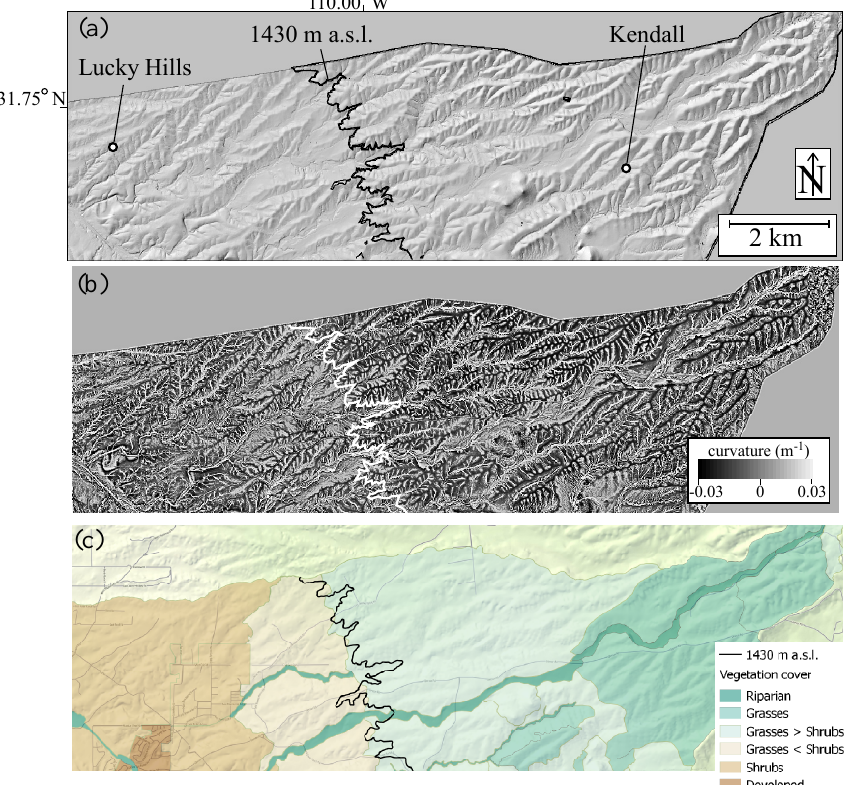
Figure 2. Relationships among landscape morphology and vegetation cover in the study area. (a) Shaded relief image of the topography, illustrating the significant increase in hillslope-scale relief from the western to the eastern portion of the study area. (b) Grayscale map of to- pographic curvature (i.e., Laplacian), demonstrating generally lower absolute hillslope curvatures (i.e., more gray) in the western (shrubland) portion of the study area relative to the eastern (grassland) portion (more black). (c) Vegetation map, after Skirvin et al. (2008), identifying the areas that are primarily shrubland, grassland, and transitional between the